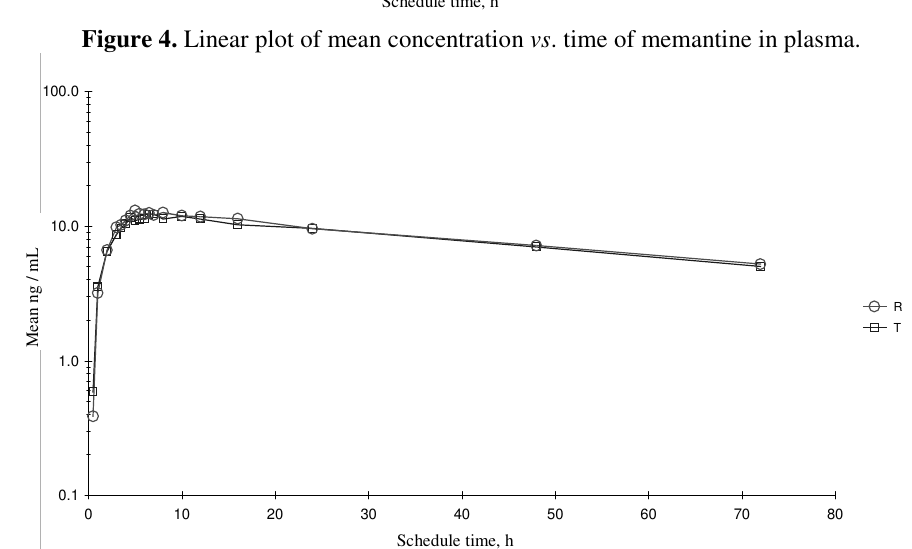
Figure 5. Log linear plot of mean concentration vs . time of memantine in plasma. Table 2. Summary statistics of pharmacokinetic parameters for memantine in